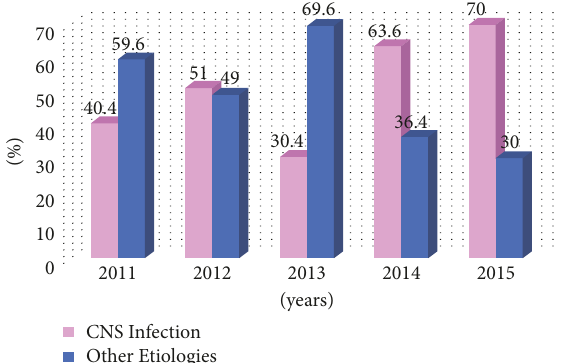
Figure 2: The proportion of patients with CNS infections to all cases with febrile encephalopathy.